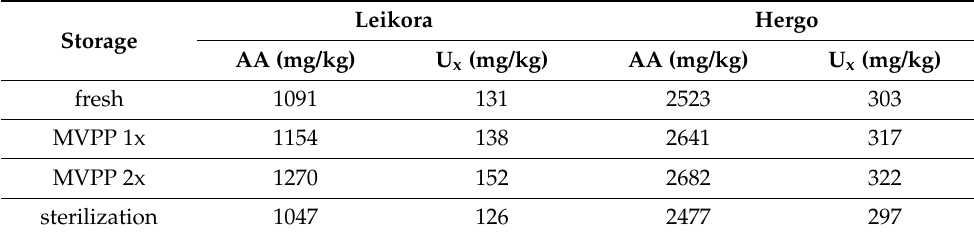
Table 4. Ascorbic acid content in sea buckthorn juice during heat